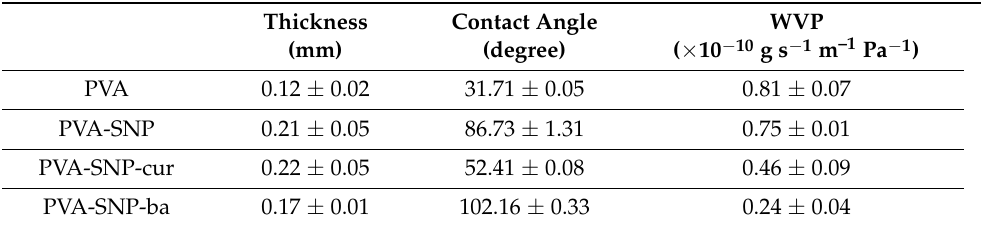
Figure 5. AFM images of ( A ) PVA, ( B ) PVA-SNP, ( C ) PVA-SNP-cur and ( D ) PVA-SNP-ba films measured in tapping mode, with a scan rate of 1.0 Hz at fixed resolution (512 × 512 data points). The contact angle of a drop of water on the prepared films was measured (Table 1). Table 1. Water contact angle, thickness and water vapor permeability (WVP) of the PVA, PVA-SNP, PVA-SNP-cur and PVA-SNP-ba